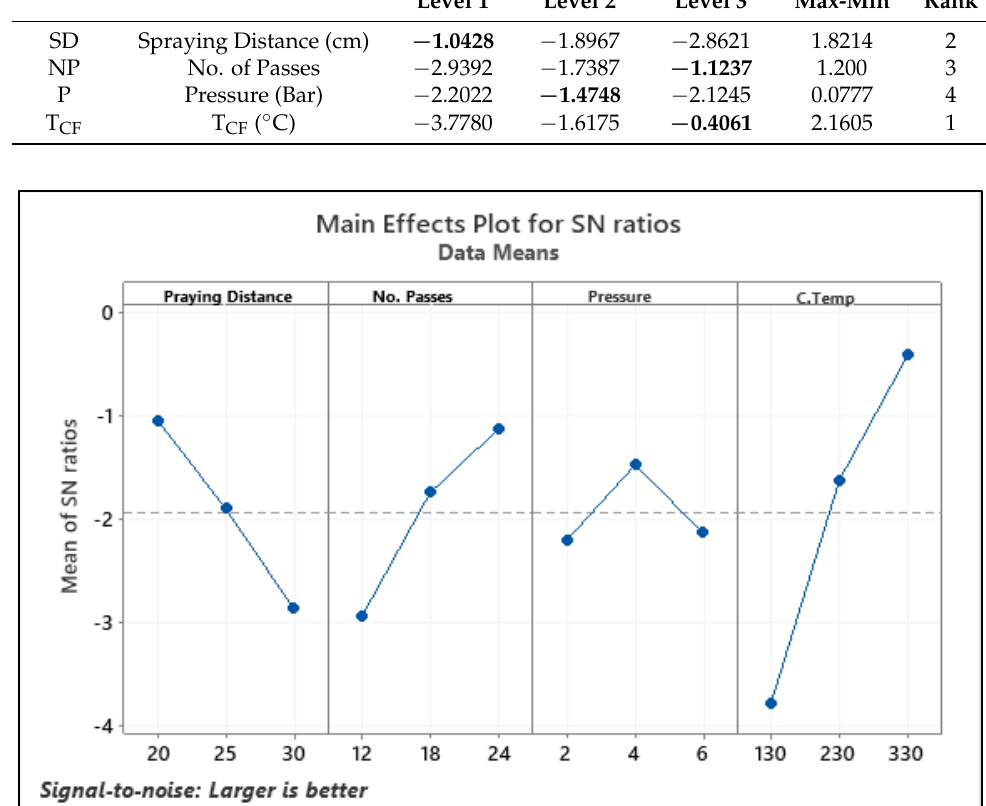
Figure 3. Mean S/N ratio of C d .